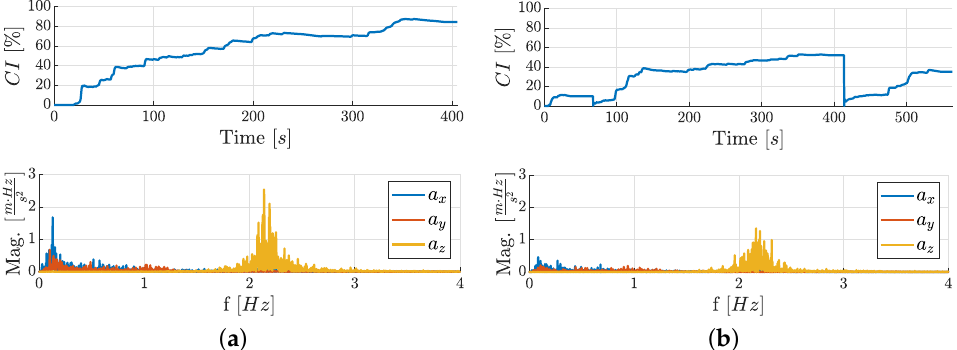
Figure 20. Comfort Index and power spectral density of the frequency-weighted accelerations a w x , y , z , for two urban driving tests, an aggressive one (upper plot), and a not-aggressive one (lower plot).